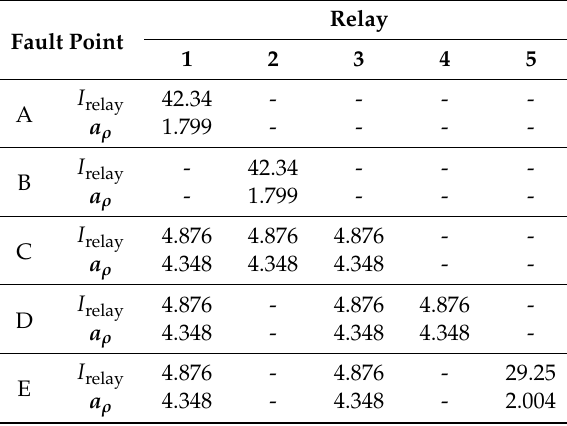
Table 7. a ρ Constants and relay currents for Case